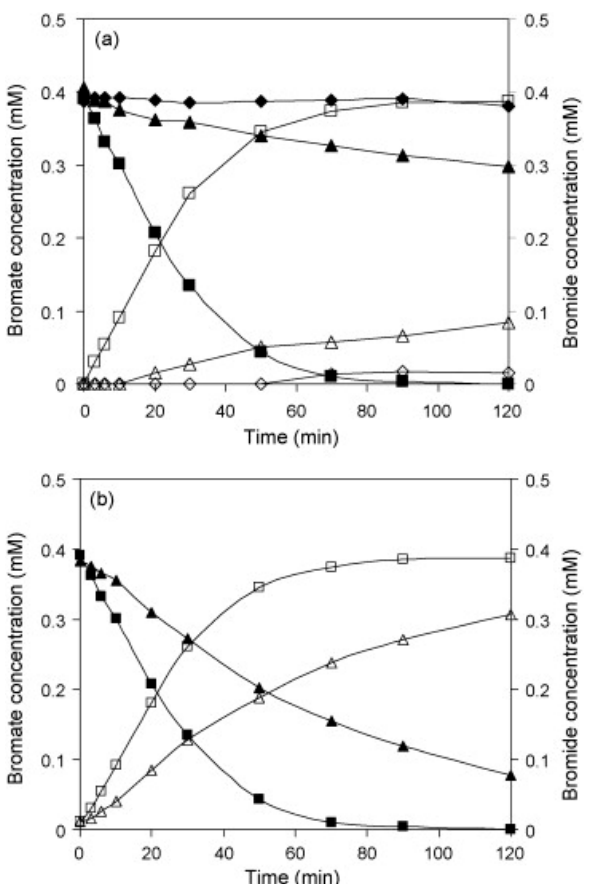
Figure 1. ( a ) Catalytic bromate reduction over ( ♦ , ◊ ) Pd(2.0)/SiO 2 , ( ■ , □ ) Pd(1.93)/ Al 2 O 3 , and ( ▲ , Δ ) Pd(2.0)/activated carbon catalysts and ( b ) catalytic bromate reduction over ( ■ , □ ) Pd(1.93)/Al 2 O 3 and ( ▲ , Δ ) Pt(2.0)/ Al 2 O 3 catalysts at pH 5.6 and 0.39 mM as initial bromate concentration. Filled symbols denote bromate concentration and open symbols denote bromide concentration. Reprinted from [61], Copyright (2010), with permission from Elsevier.